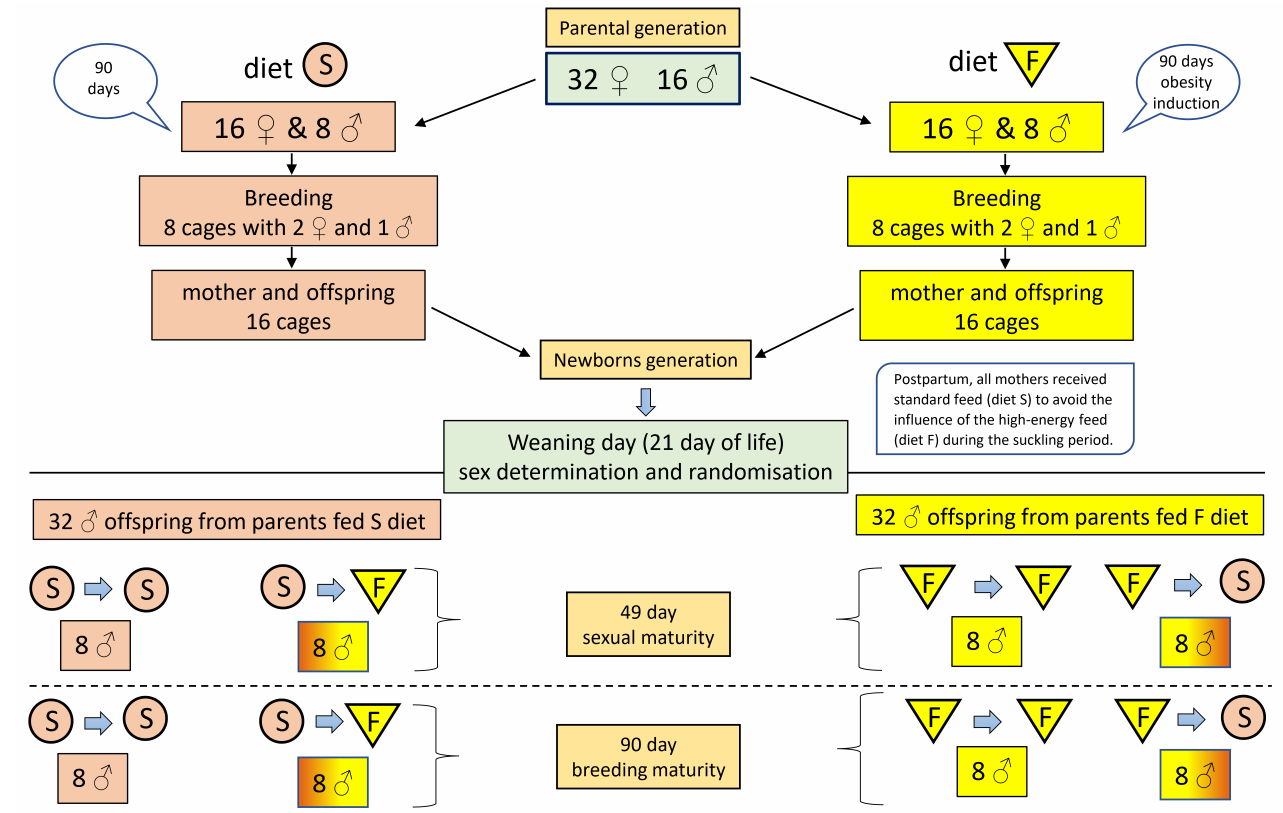
Figure 1. Experimental design. F—high-energy diet; S—standard